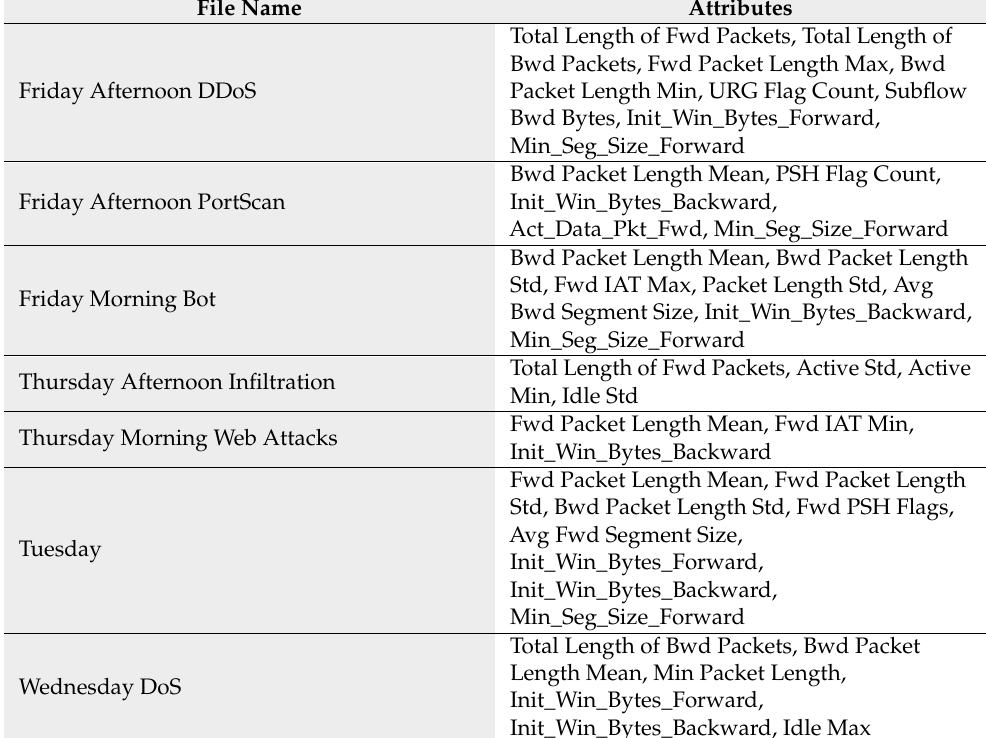
Table 5. Attributes selected considering the different types of attack (multiclass classification).